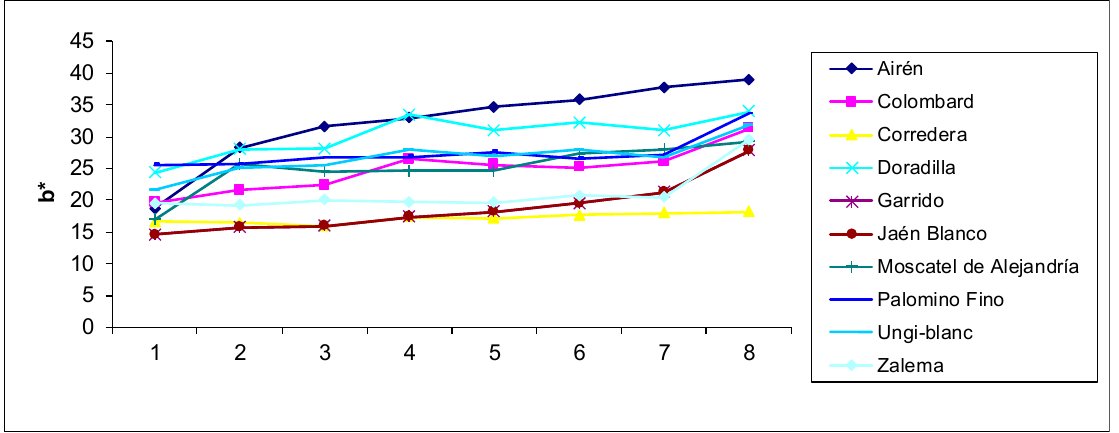
Figure 1. Evolution of the b* values in the aged distillates of the different varieties. Sample 1 corresponds to the first sampling, and sample 8 corresponds to the last one. b*: positive yellow-green tonality values.